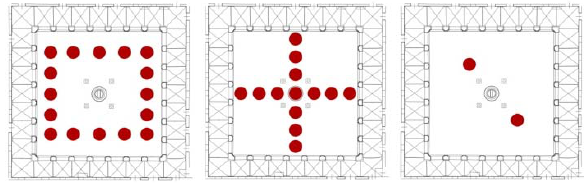
Figure 3. The three acquisition geometries: the “square” scheme, the “cross” scheme and the position of the two